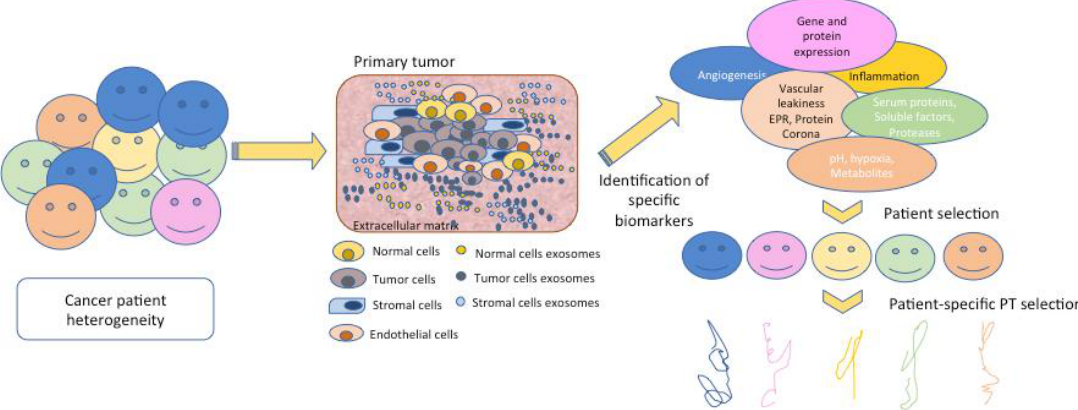
Figure 1. The basis of personalized medicine is the knowledge of the environment, in this case the tumor’s microenvironment in each patient. The basic players of this disease include normal cells, tumor cells, the vasculature and the stroma, but the signals sent by these components and their features are different and give rise to patient-specific tumor heterogeneity. The identification of signals such as membrane receptors, proteases, angiogenic factors, and opsonins among others are key for the design and development of polymer therapeutics (PT) and the selection of those patients with maximal response.